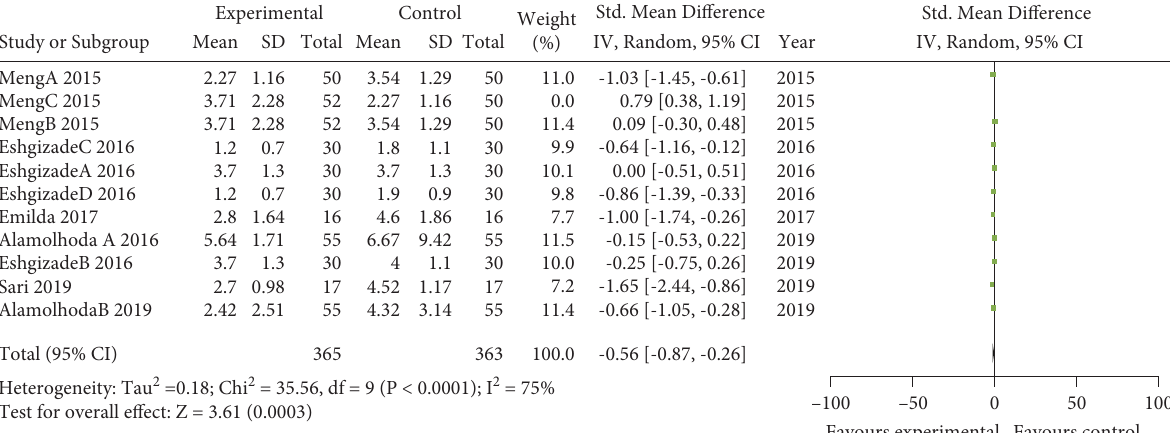
Figure 6: Te forest plot of sensitive analysis of nipple